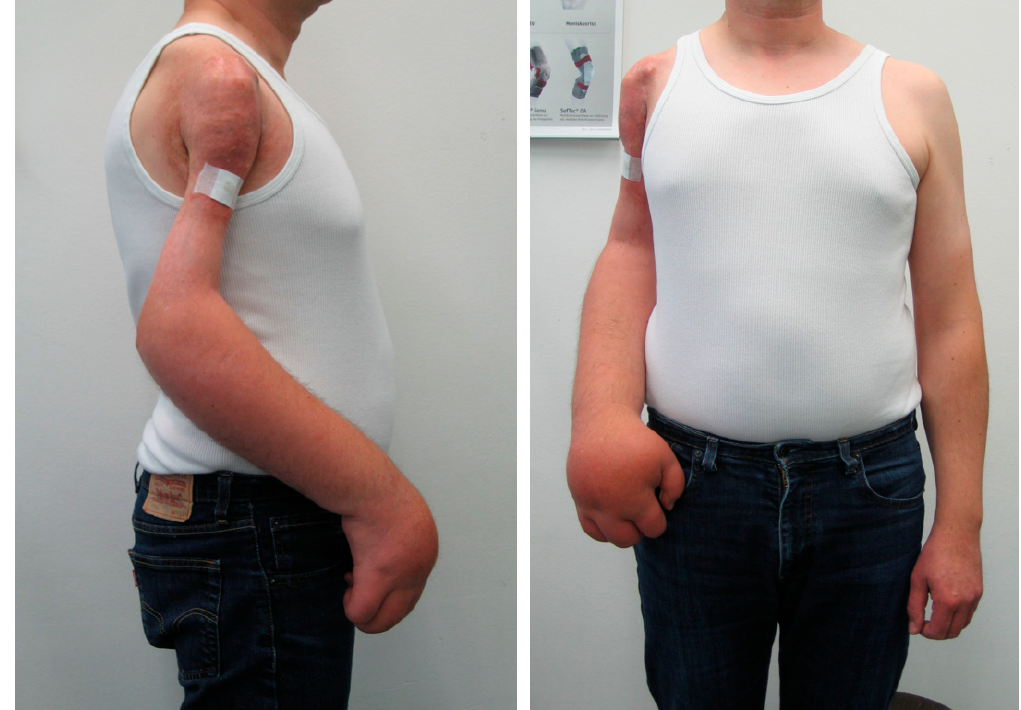
Figure 3. More than 30 years after treatment of a Ewing sarcoma of the humerus with local radiation and chemotherapy complications such as chronic osteomyelitis, nerve palsy and edema, an amputation due to functional reasons was indicated.